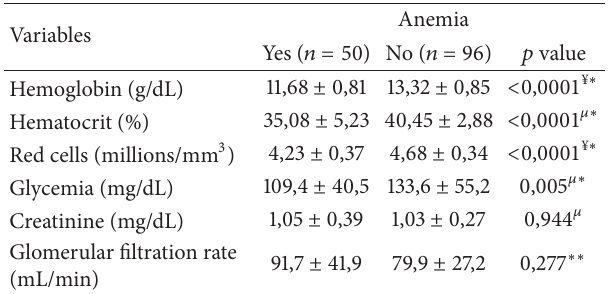
Table 2: Biochemical and hematological variables in patients with DM2 according to the presence of anemia.